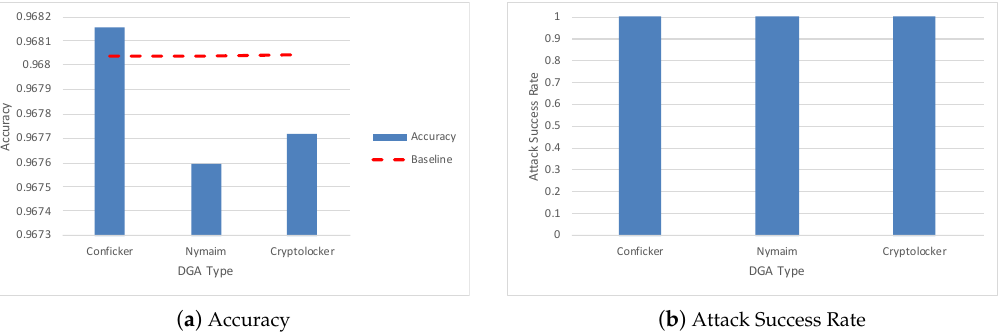
Figure 3. ( a ) The BA of TLD-trigger backdoor attack based on different DGAs and ( b ) the ASR of TLD-trigger backdoor attack based on different